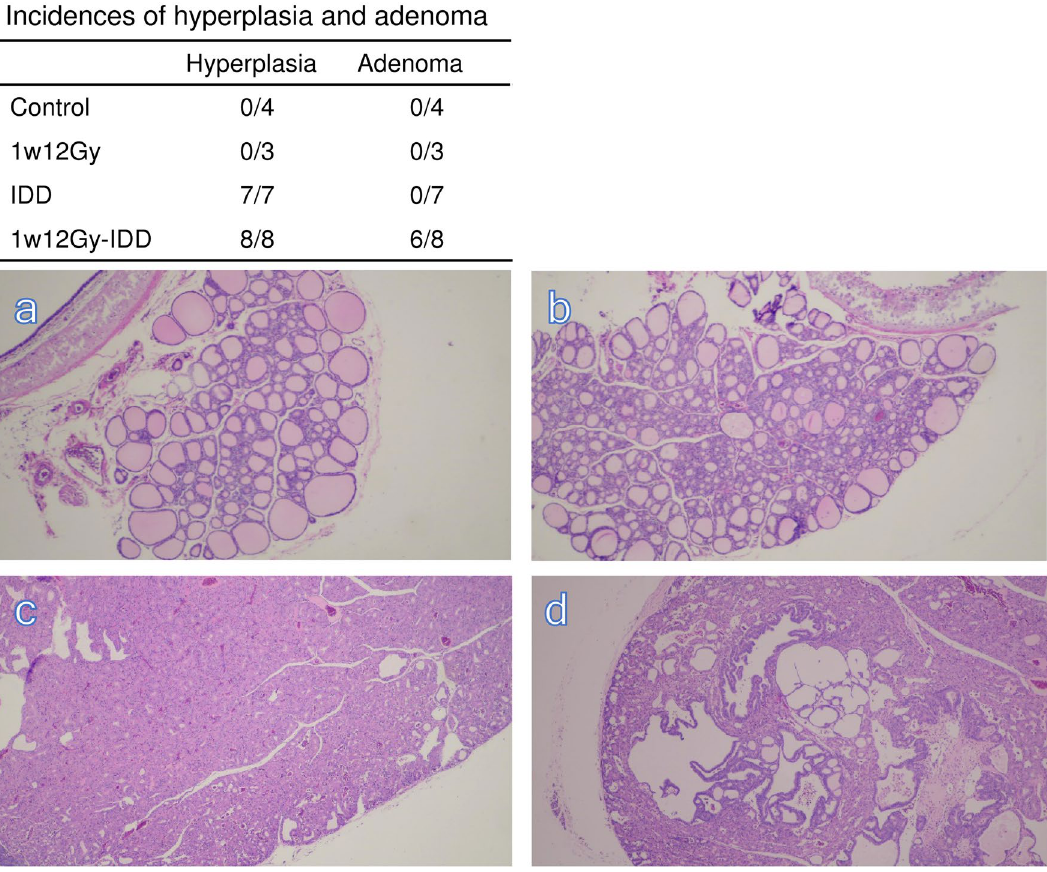
Figure 3. Thyroid tumors developed in neonatally X-irradiated rats fed with IDD at 29 weeks old. Representative H.E. staining of the thyroid in Control ( a ), 1w12Gy ( b ), IDD, diffused follicular hyperplasia ( c ), and 1w12Gy-IDD, follicular adenoma ( d